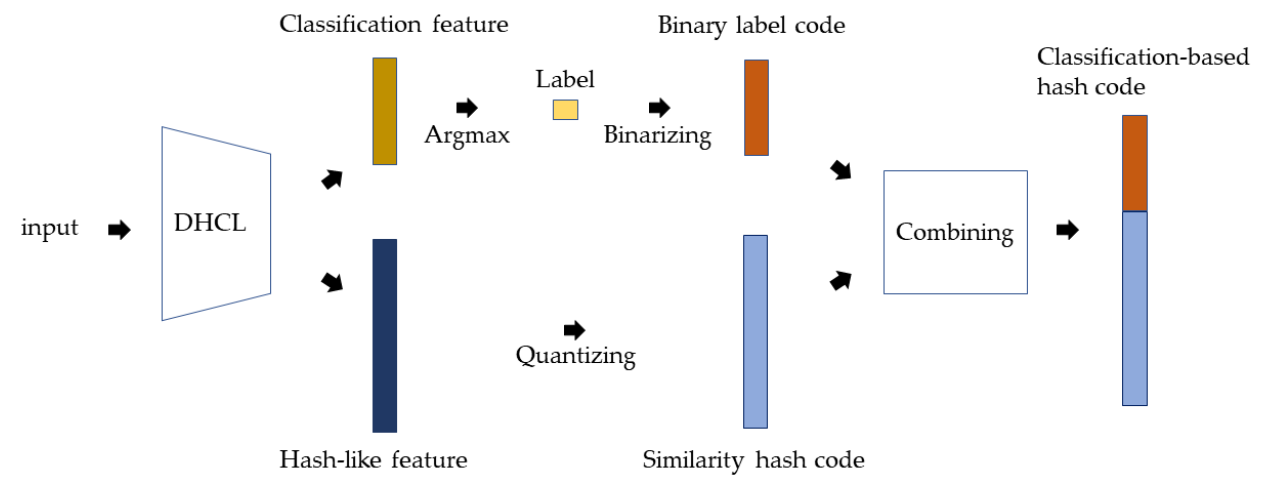
Figure 4. The generation of classification-based hash codes. The class with the highest probability among the classified features is taken as the predicted label of the sample and then binarized to obtain the binary label code. The low-dimensional hash-like features obtained by the deep hash network are quantized to obtain similarity hash codes. The binary label code and the similarity hash code are concatenated to obtain the final hash code for retrieval.